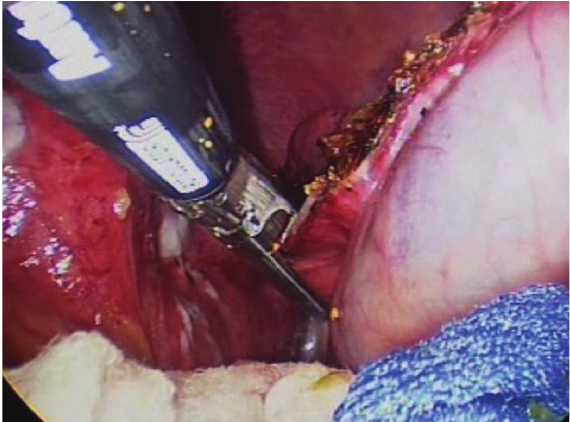
Figure 6: Excision of cyst wall using endo-GIA stapler with 2.5 mm vascular